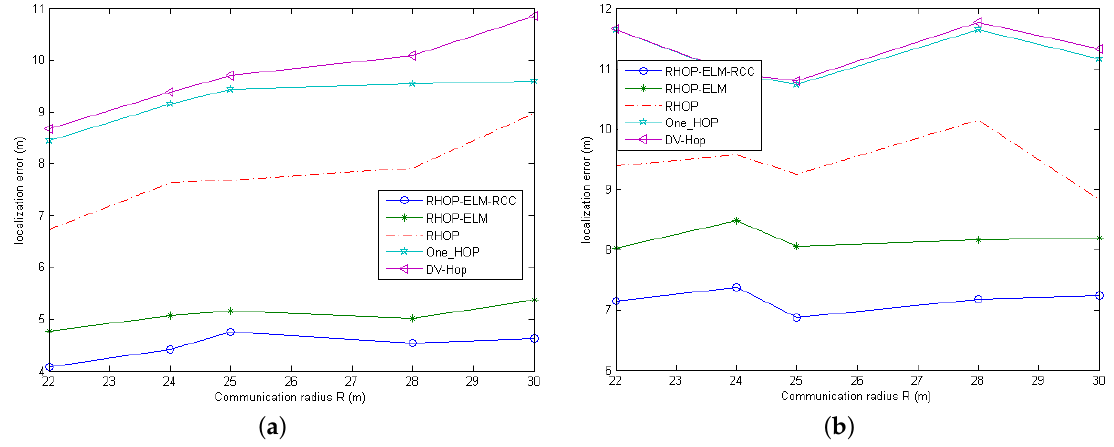
Figure 3. The impact of R in different areas. ( a ) The location error against R in the area of 50 m × 50 m; ( b ) The location error against R in the area of 100 m × 100